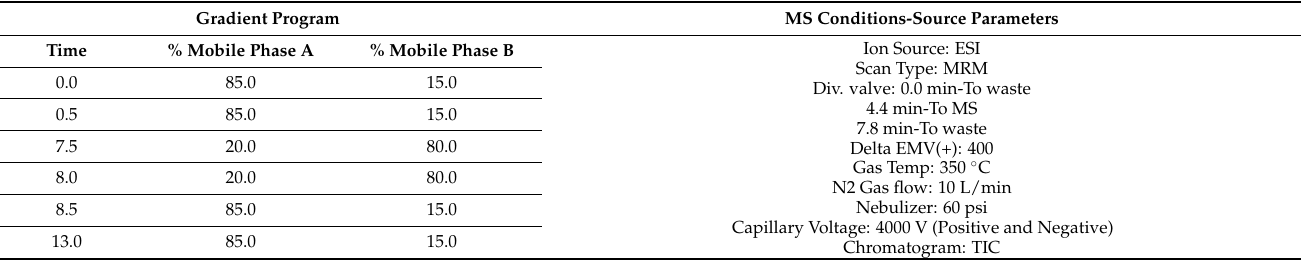
Table 5. Gradient program of the mobile phase and MS